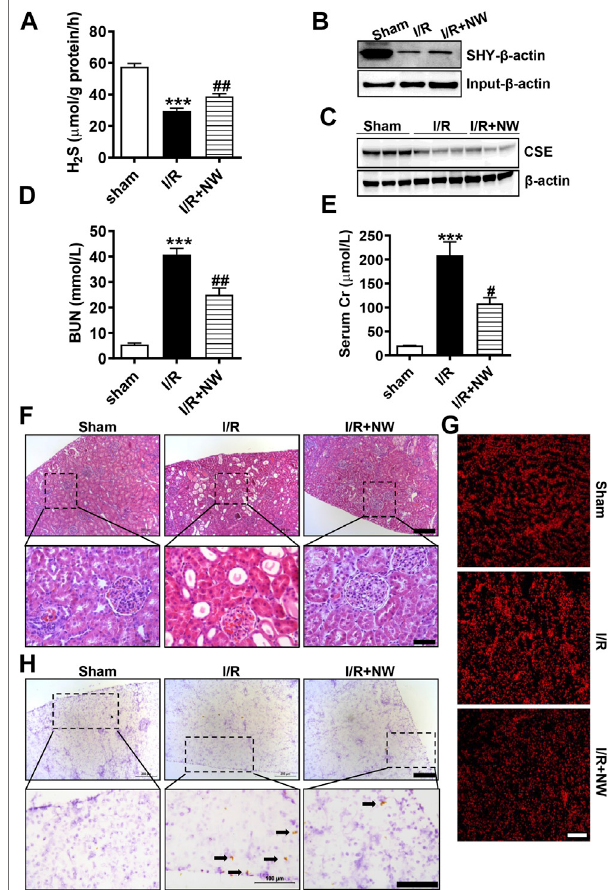
FIGURE 4 | NW is protective against acute kidney ischemia – reperfusion injury. 1 h after kidney ischemia and 24 h after reperfusion, H 2 S production in the kidney was detected (A) . The modi fi ed biotin switch assay determined sulfhydrated β -actin (SHY- β -actin) expression (B) . Western blot analysis ofCSEproteinlevels (C) .Bloodureanitrogen (D) andserumCr(creatinine) (E) contentsinsham,I/R,andI/R+NWgroups.H&Estainingshowedchangesof morphology in the kidney (F) . Upper panel: scale bar (cid:2) 200 μ m; lower panel: scale bar (cid:2) 50 μ m. DHE staining indicated the oxidative stress level (G) , scale bar (cid:2) 200 μ m. Immunohistochemical staining of cleaved caspase 3 in the kidney (H) .Upperpanel:scalebar (cid:2) 200 μ m;lowerpanel:scalebar (cid:2) 100 μ m. Black arrows point out the positive cells. N (cid:2) 6/group. * Versus sham, # versus